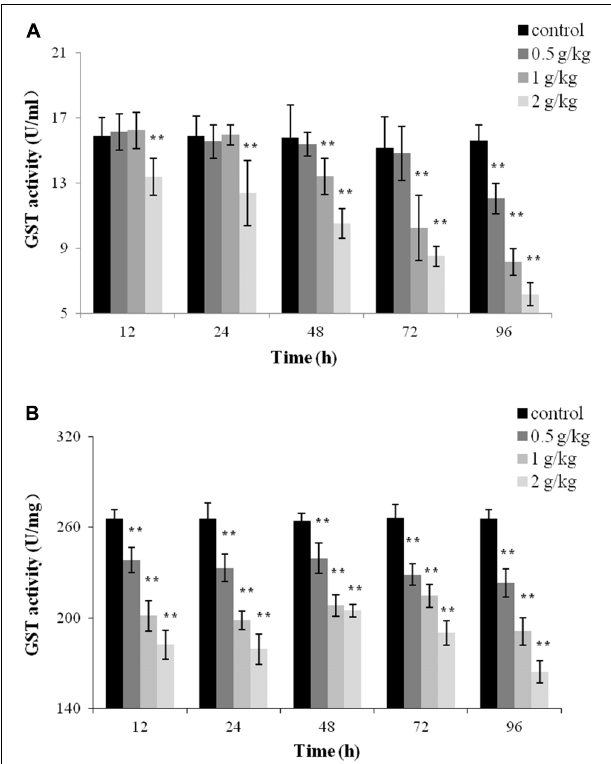
FIGURE 3 | Glutathione S-transferase (GST) activity of Carassius auratus gibelio after a single dose of 0.5 g/kg, 1 g/kg, or 2 g/kg trichlorfon. (A) Changes in GST activity in plasma after a single dose of trichlorfon; (B) changes in GST activity in liver tissues after a single dose of trichlorfon. Asterisks indicate values that are significantly different from the control values, ∗ P < 0.05; ∗∗ P < 0.01, n =